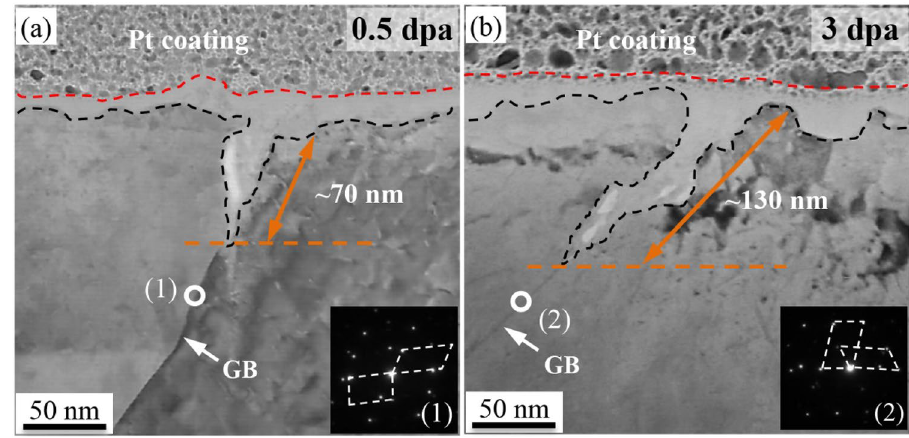
Figure 2. TEM observation of the oxide at the grain boundary in ( a ) 0.5- and ( b ) 3-dpa irradiated 304NG SS.